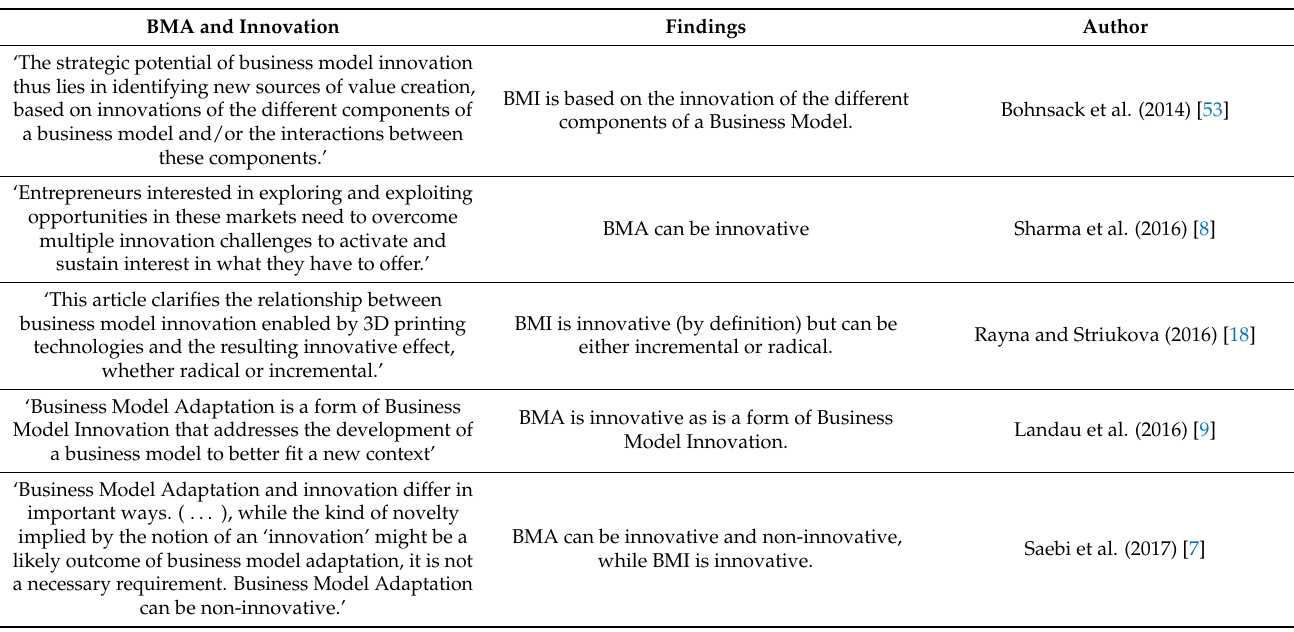
Table 7. Innovation in BME, BMA, and